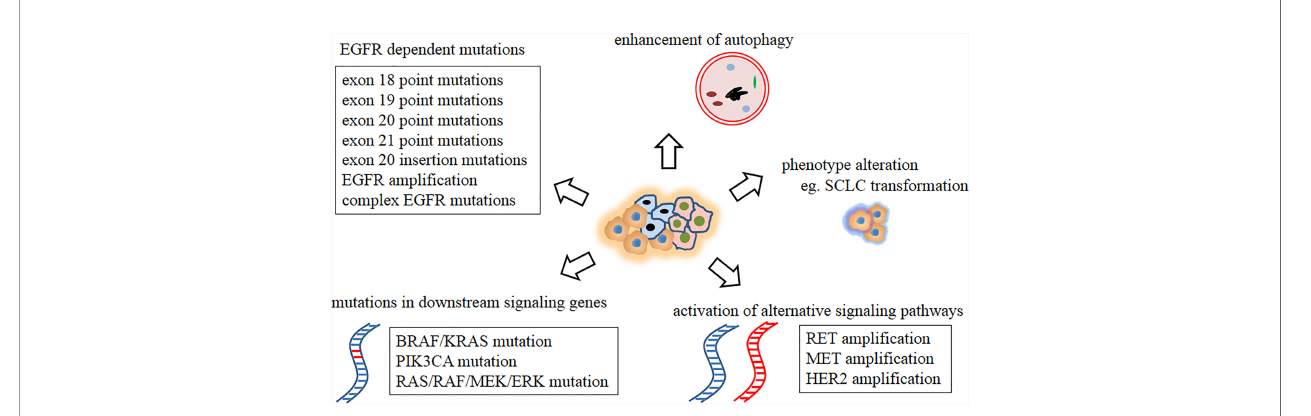
FIGURE 1 | Mechanisms of drug resistance to EGFR TKIs. EGFR, epidermal growth factor receptor; SCLC, small cell lung cancer; TKI, tyrosine kinase